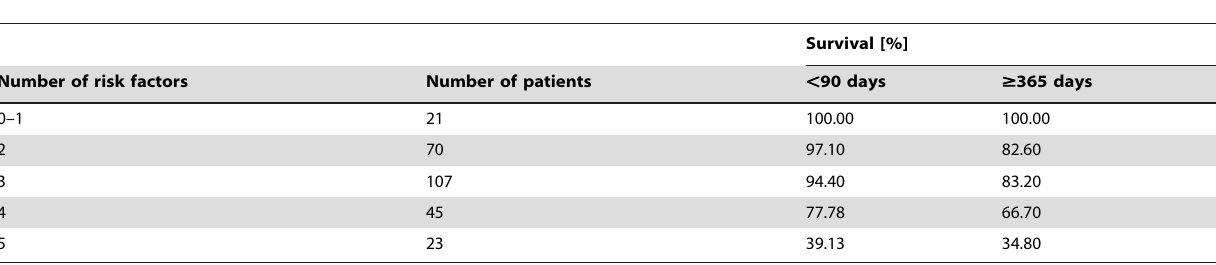
Table 6. Risk Factor score and patient survival